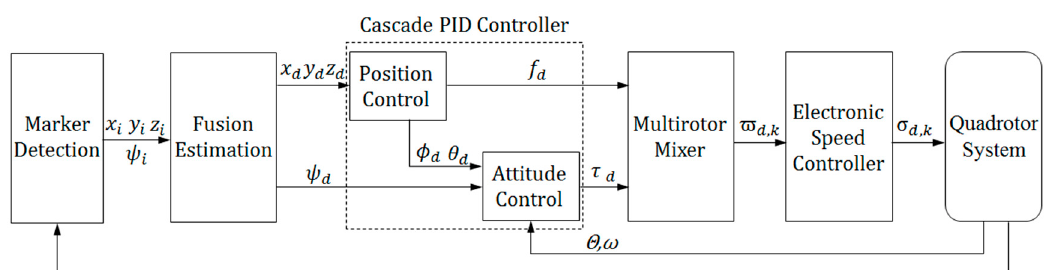
Figure 5. Hierarchical control architecture of a quadrotor.